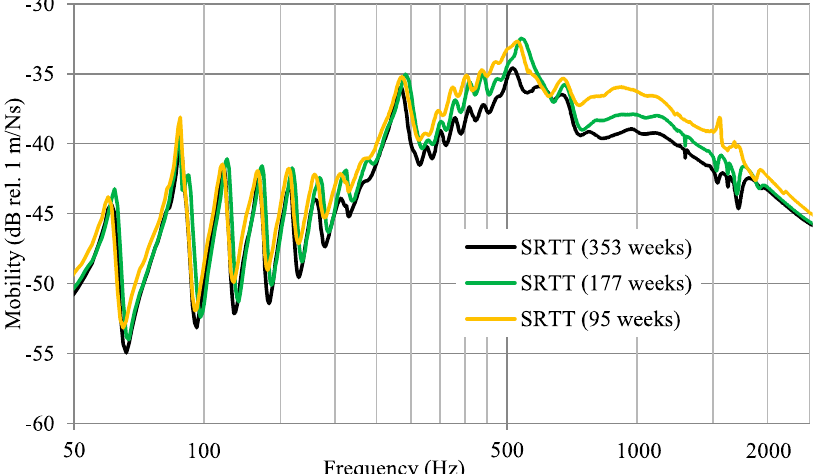
Figure 13. Comparison of measured mobility spectra for SRTT tires of different age (source from Schubert et al., 2016 [116], Figure 8; reprinted with permission from Mr. Manuel Männel of Müller-BBM GmbH, Germany).